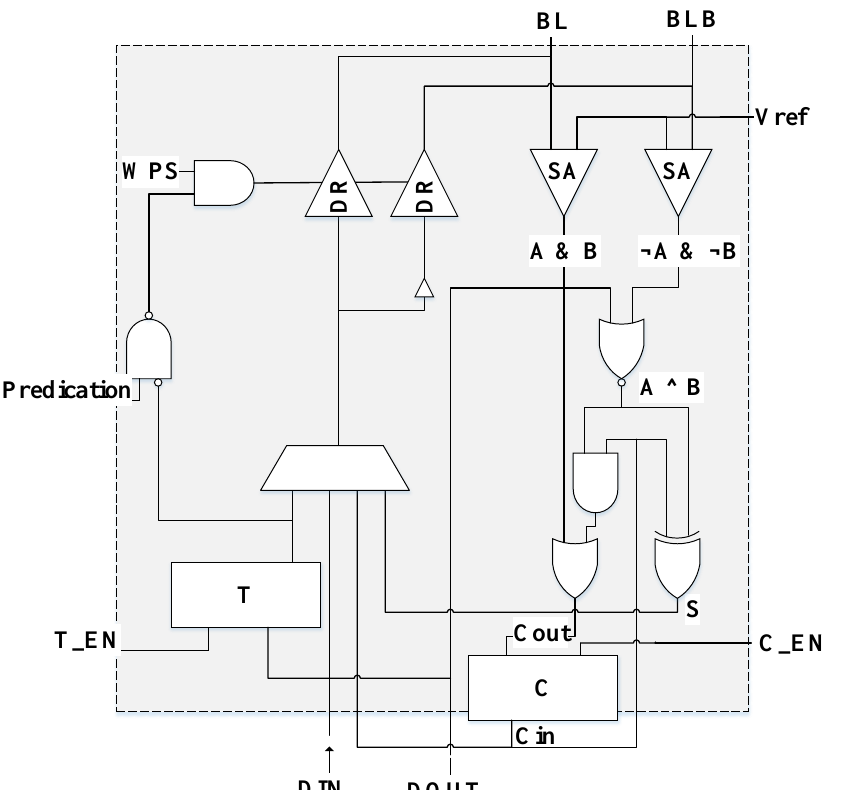
Figure 13. Bitline peripherals in Neural Cache (adapted from